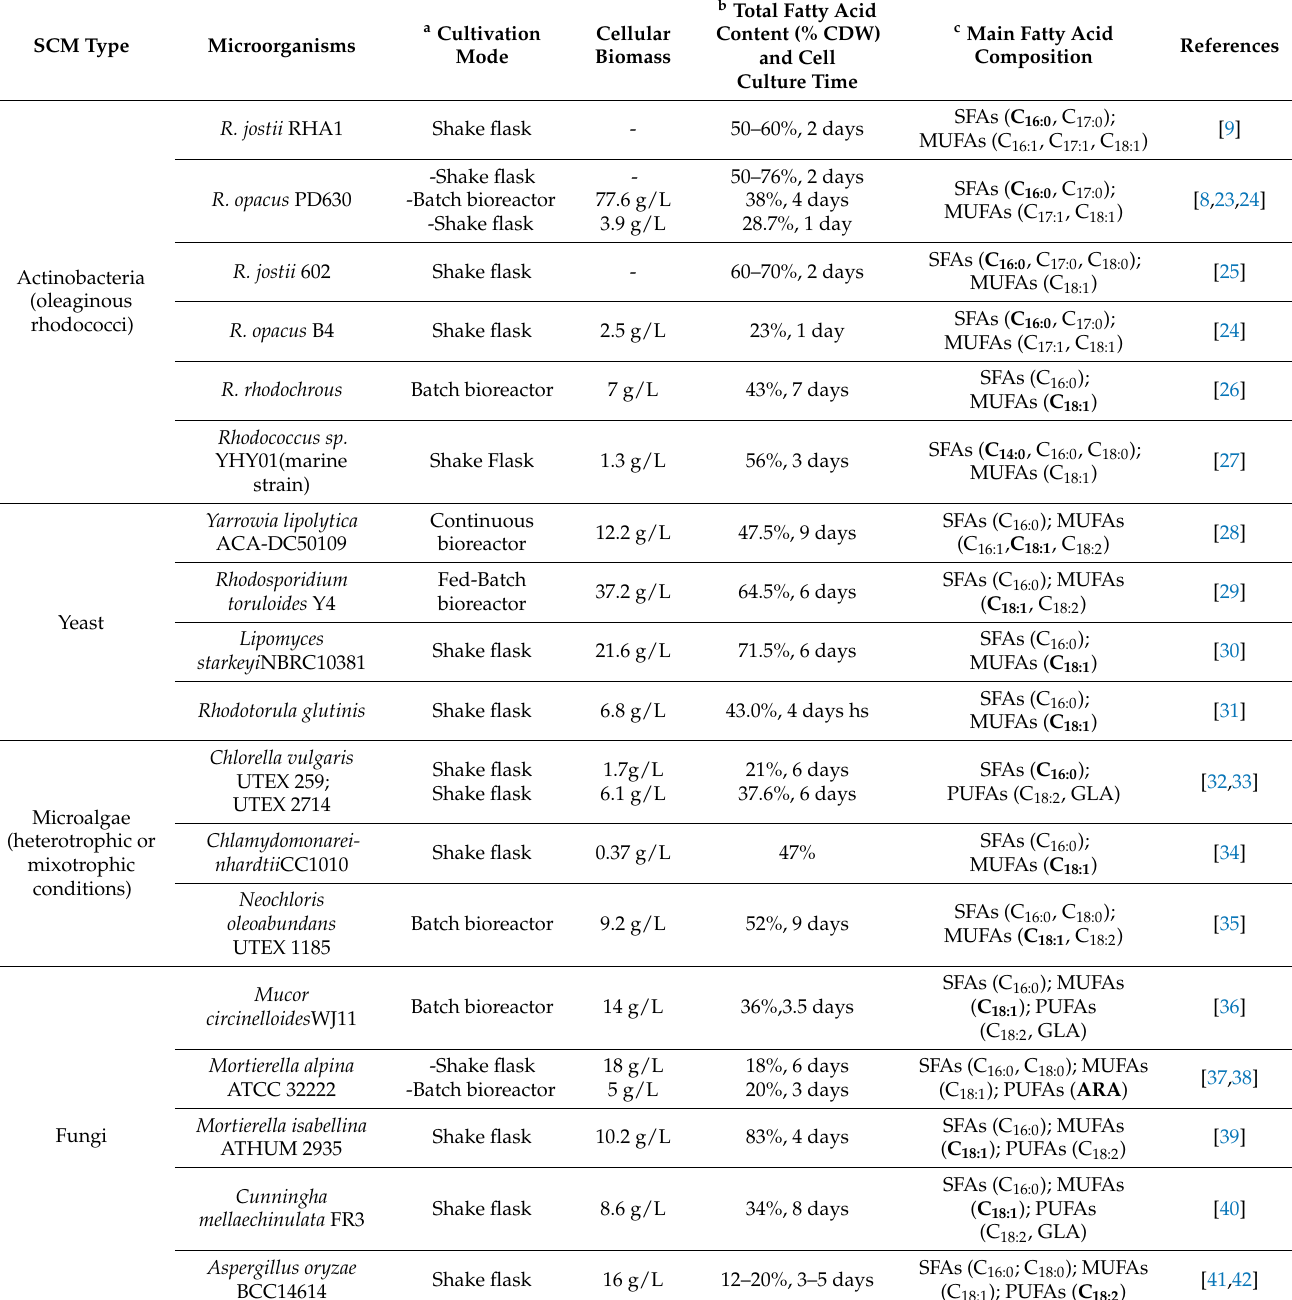
a For a better comparison, all data were based on strains that were grown under a high C/N ratio conditions with glucose as the sole carbon source. b Refers to total fatty acid content in parental strains without any genetic modification for lipid content improvement. c Only fatty acids greater than 10% were considered. The highest component is highlighted in bold . References. PUFAs: polyunsaturated fatty acids; MUFAs: monounsaturated fatty acids; SFAs: saturated fatty acids; ARA: arachidonic acid; GLA: γ -linolenic